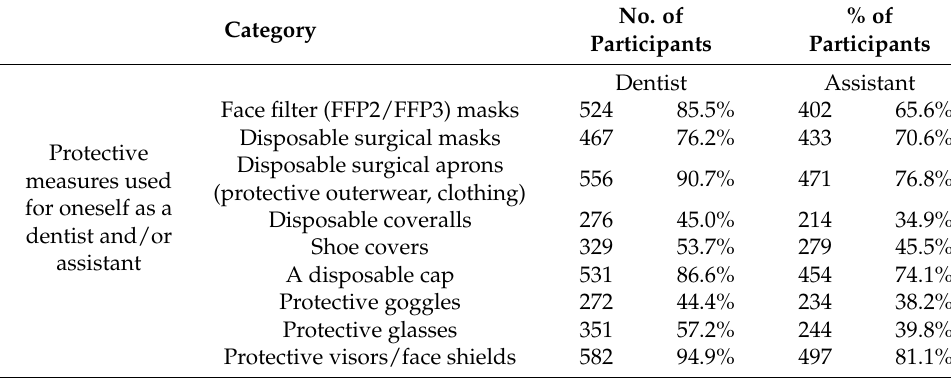
Table 4. Protective measures taken by dentists used for oneself and/or